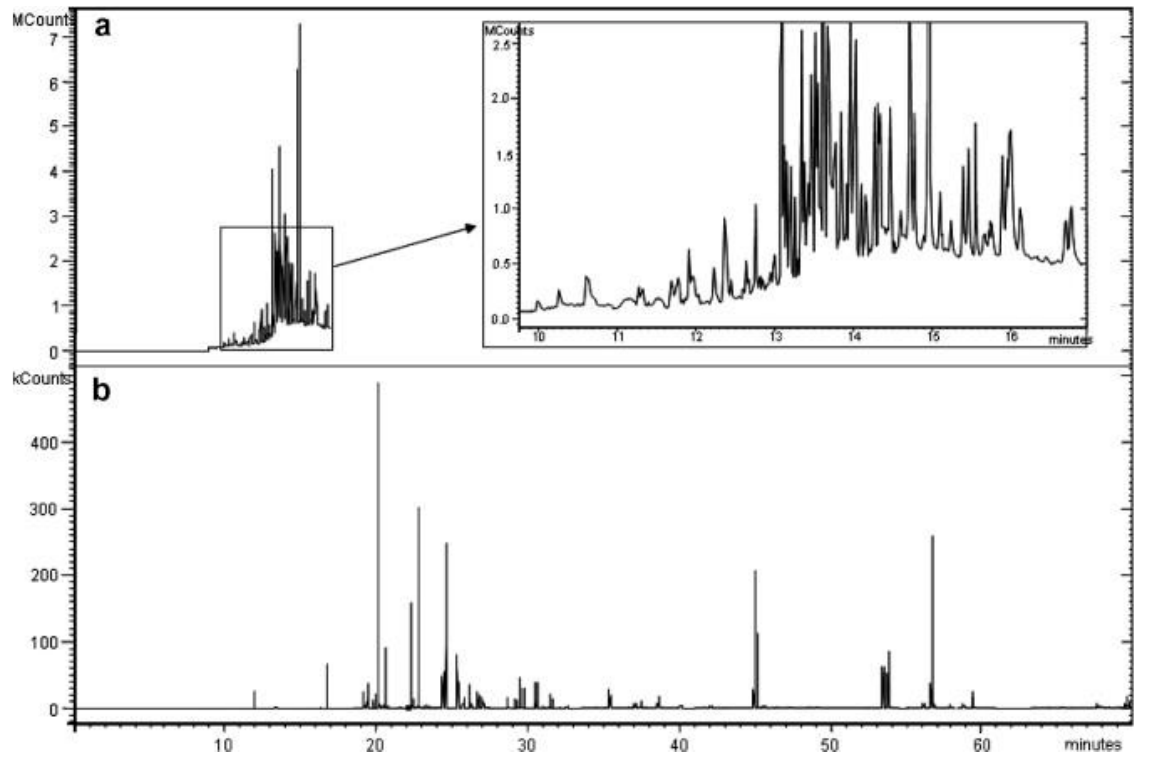
Figure 2. Chromatograms obtained for the analysis by the SPME-GC method of an orange juice spiked with multiple target pesticides at a concentration of 0.05 mg L − 1 ( a ) obtained with the GC-MS screening full scan method and ( b ) obtained with the confirming/quantifying MS/MS method. Reprinted with permission from Ref. [39]; 2008, Elsevier. Table 1. Summary of the methods discussed in this review for the two main groups of samples, food and